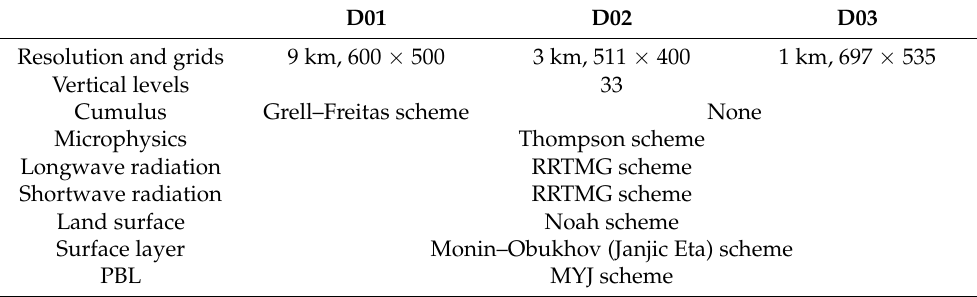
Table 1. Configuration of the model